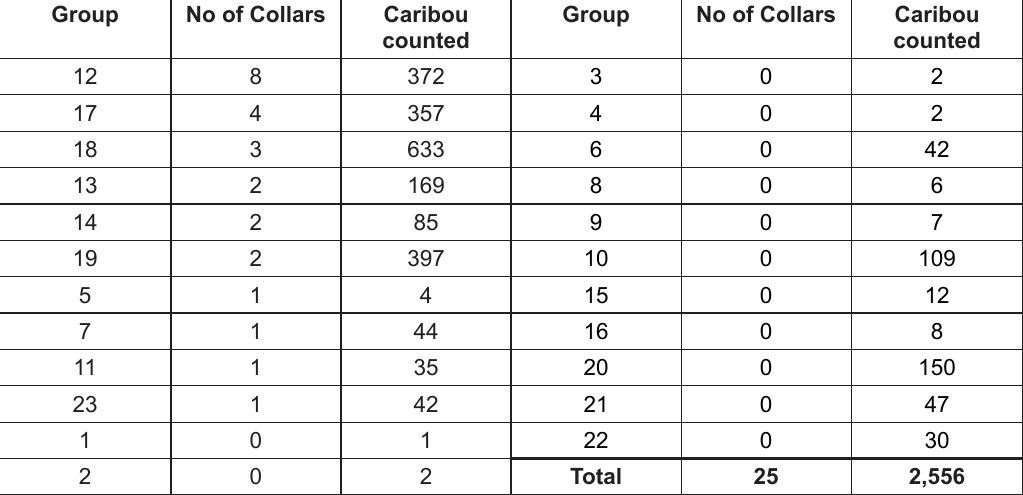
Table 39: Post calving field data from Tuktoyaktuk Peninsula herd on July 13, 2009. Group No of Collars Caribou Group No of Collars Caribou counted